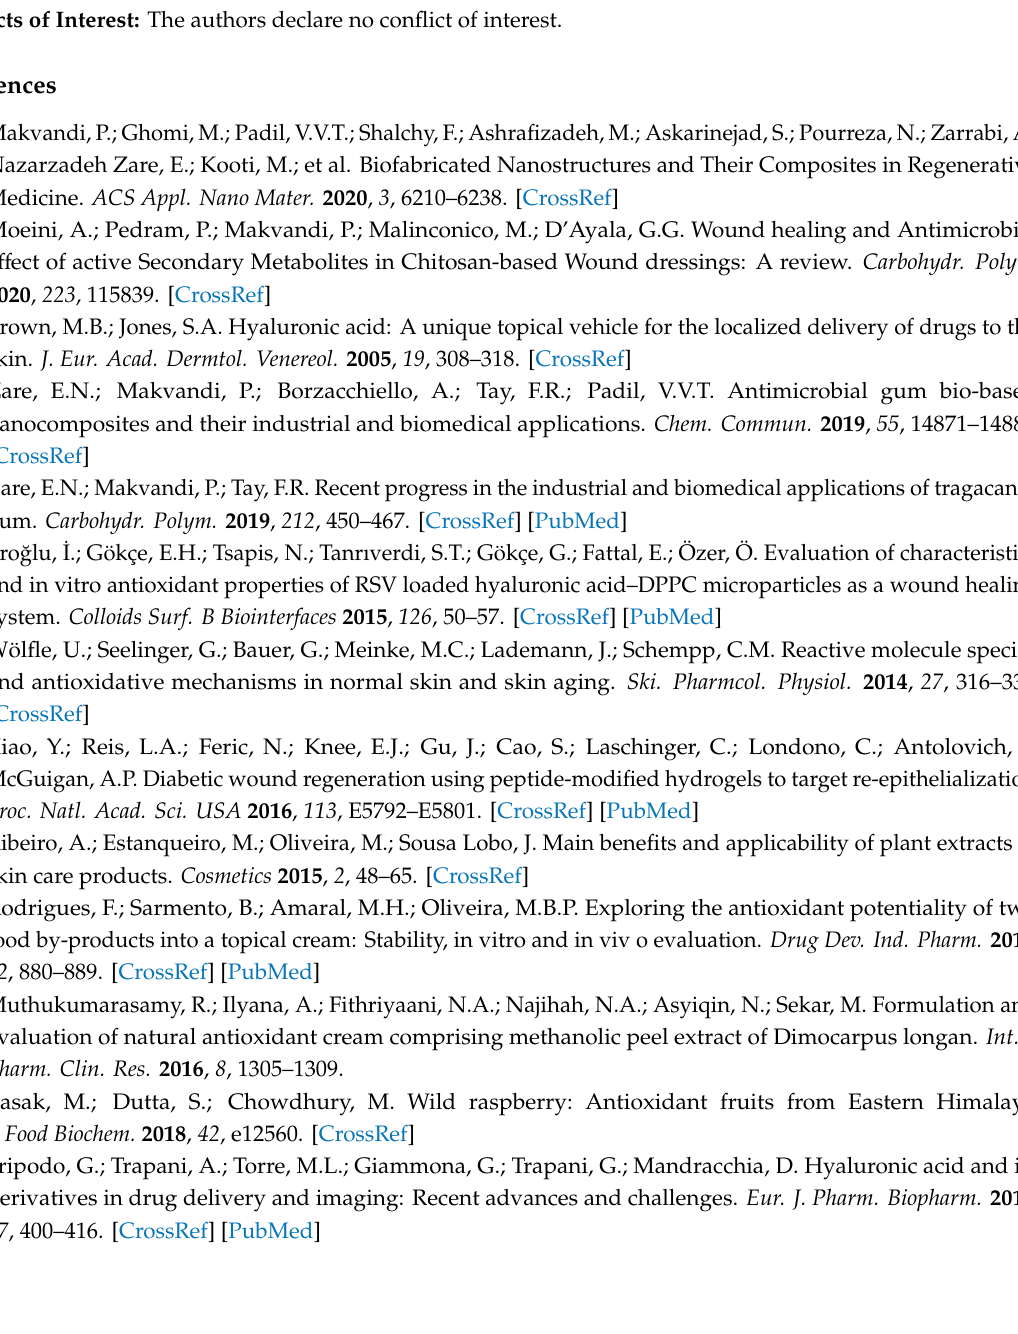
Figure S1: Safety and allergic tests for the base and herbal